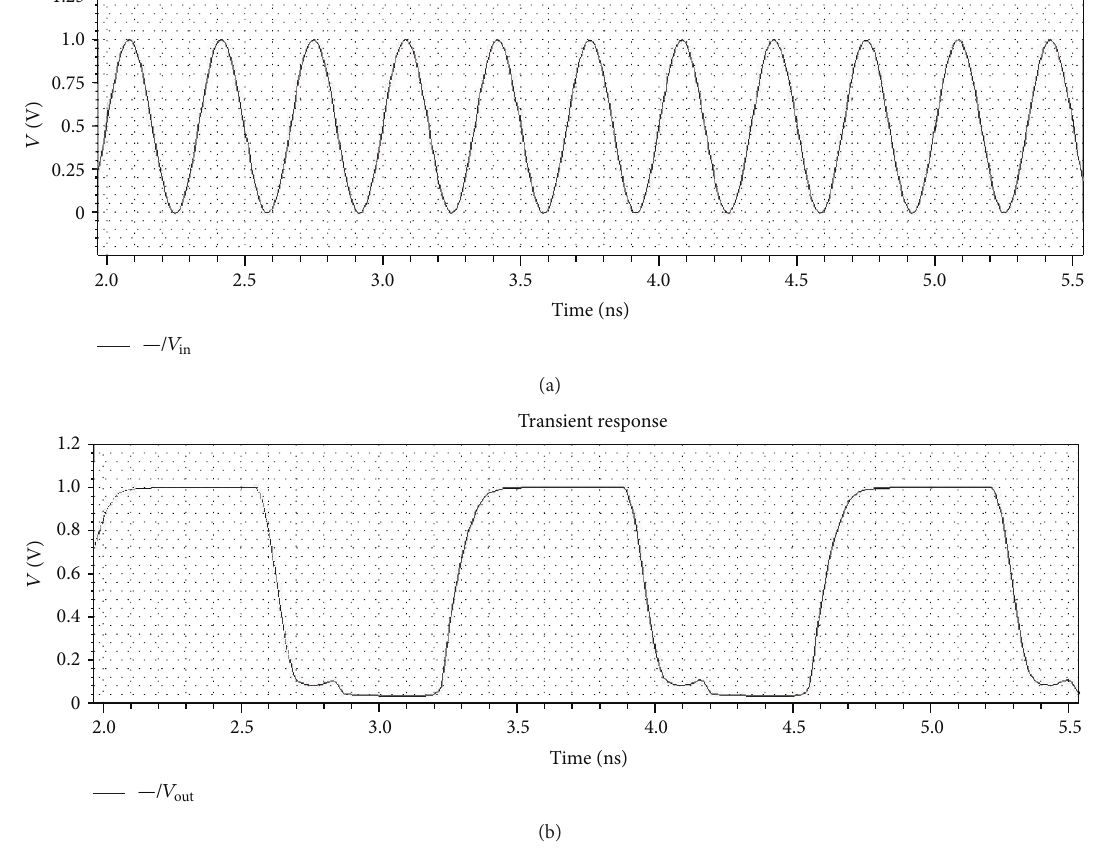
Figure 6: Sine input at 3 GHz and resulting output. Table 3: Measured operating parameters of the proposed circuits.